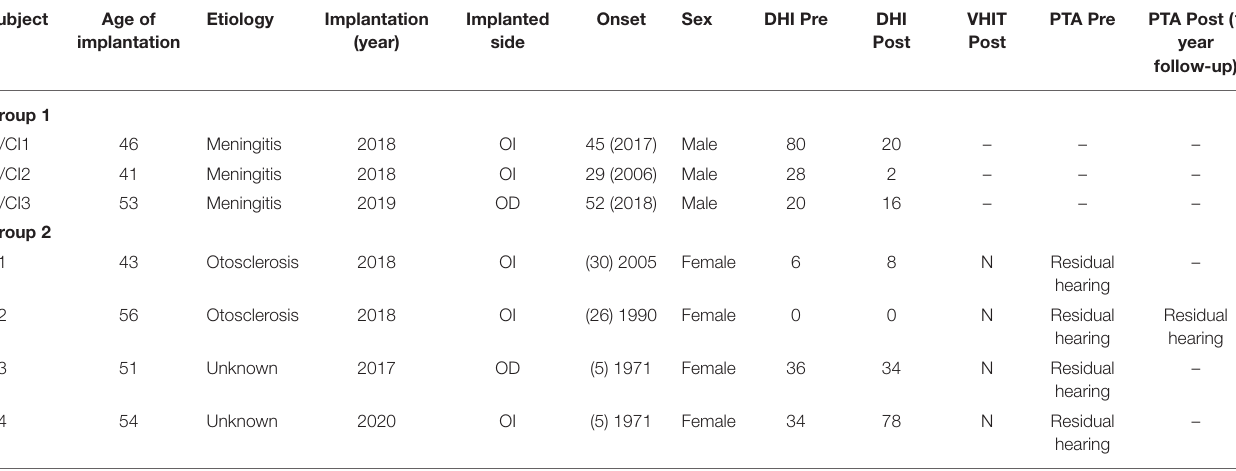
TABLE 1 | Clinical data of both vestibular and cochlear implanted patients (group 1: cochleo-vestibular implant; group 2: cochlear implant).